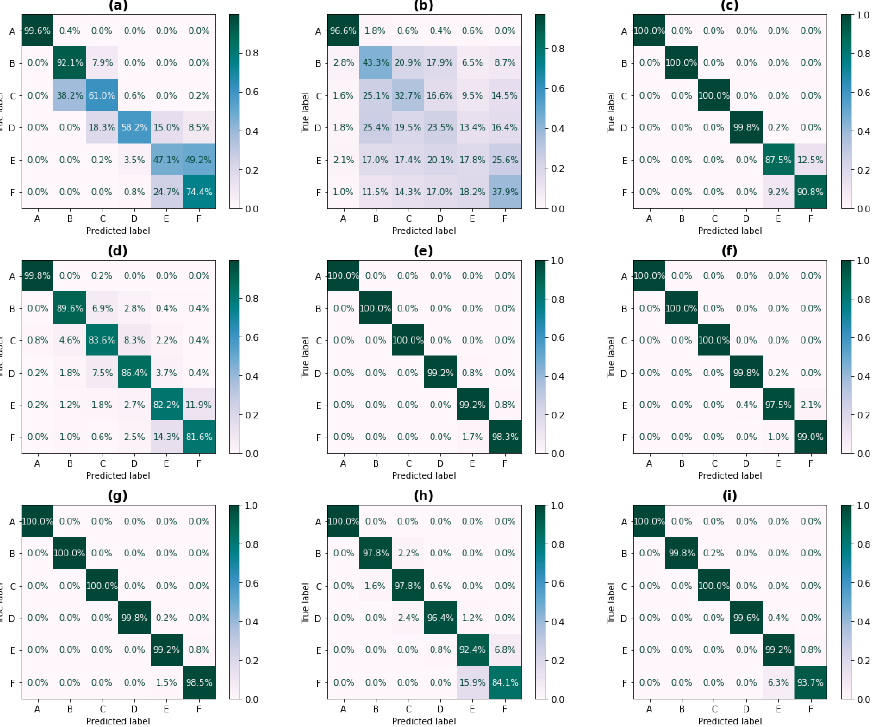
Figure 8. Confusion matrix by ( a ) LR, (b ) SVM-Lin, ( c ) SVM–RBF ( C = 100), ( d ) KNN, ( e ) DT, ( f ) RF, ( g ) GBC, ( h ) MLP, ( i )